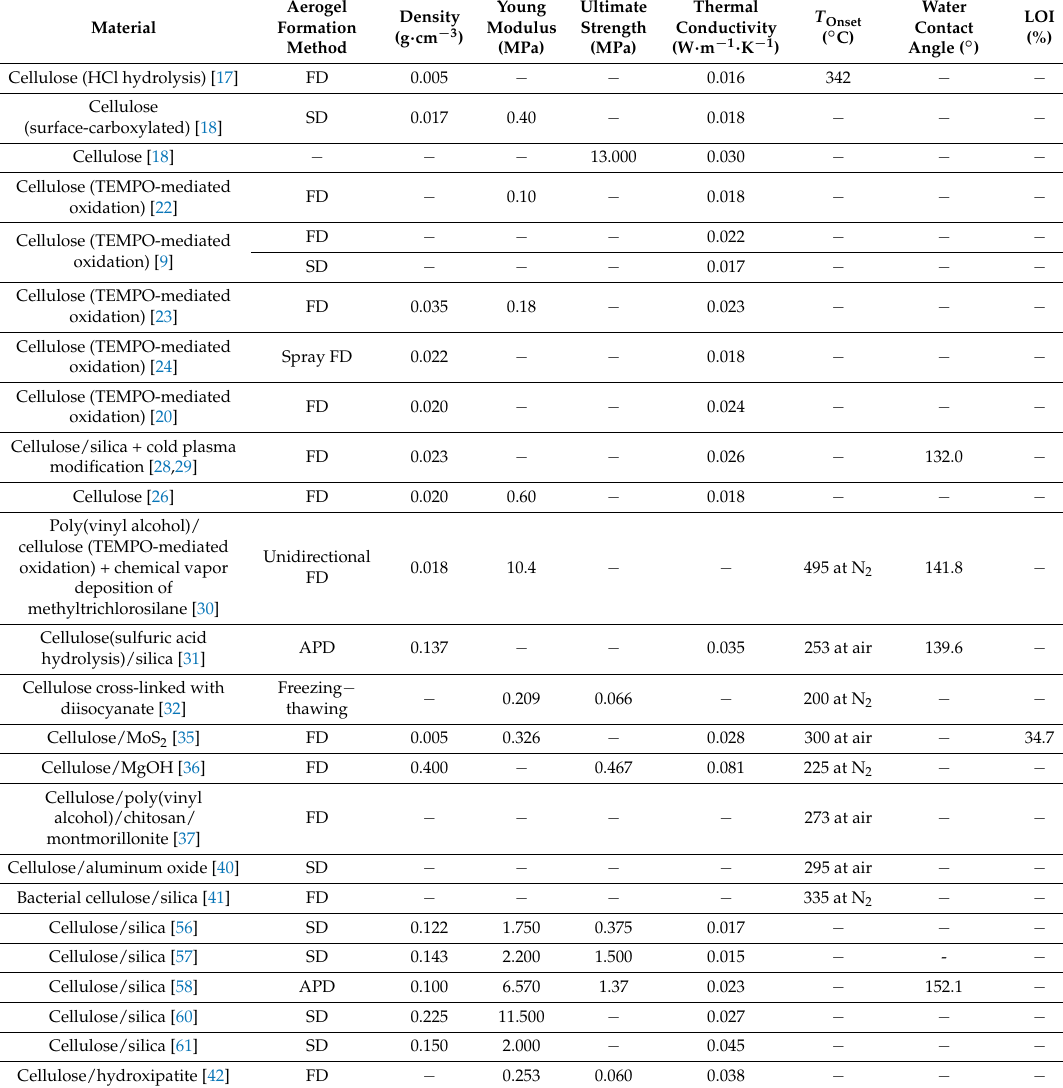
Table 2. Properties of interest for selected cellulose aerogels gathered from scientific articles published within the last five